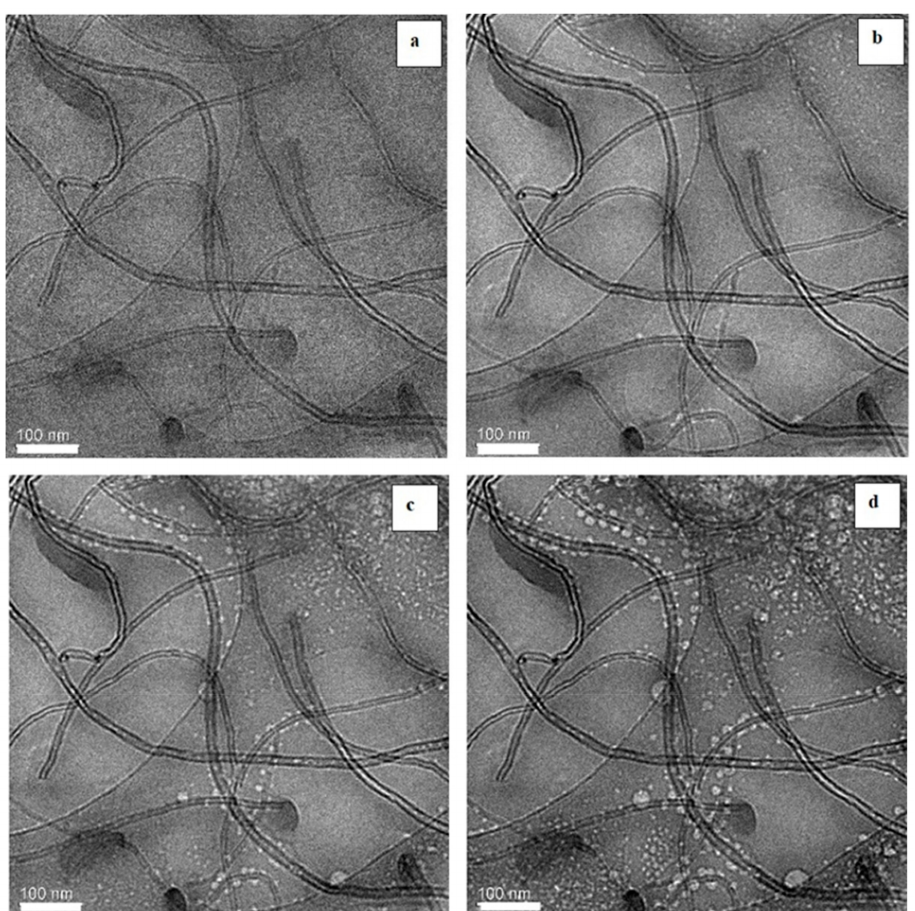
Figure 3. Micrographs of 0.5 wt.% MWCNT + 1 wt.% dS4VP dispersion in DMF, of the same area taken at increasing electron irradiation: exposures of about 1200, 2400, 3600, and 4800 e/nm 2 , ( a – d , respectively).